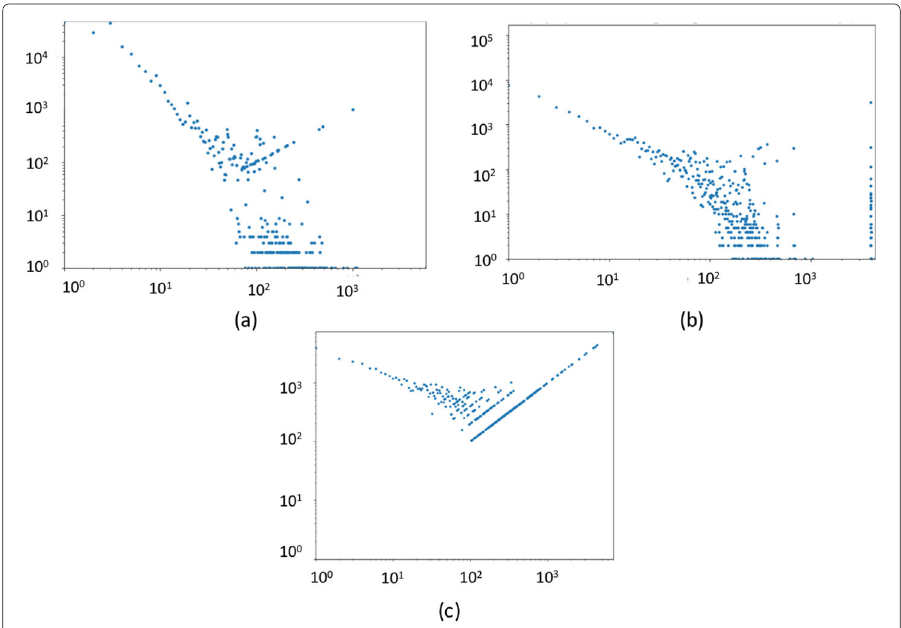
Fig. 9 Degree distributions of higher-order networks. a , b and c respectively refer to networks G ∗ o , G o o , and G i o . The x-axis is the degree, and the y-axis is the frequency of the